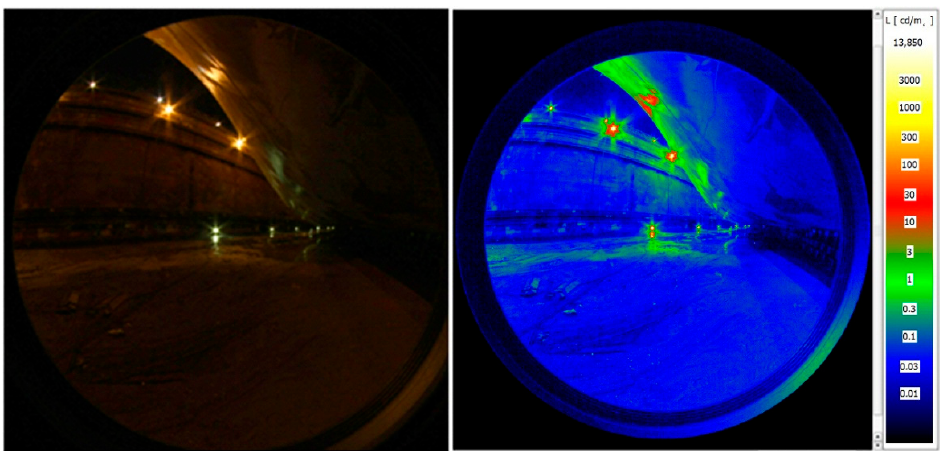
Figure 6. The view from the measurement point with corresponding luminance map. Measured GR = 66, subjective sensation of glare: disturbing, task of activity [5]: Cleaning of ship hull, GR MAX from standard [5] = 50. Similar to Figure 5, in this case, the location of the glare sources determined the high level of glare (high GR value).